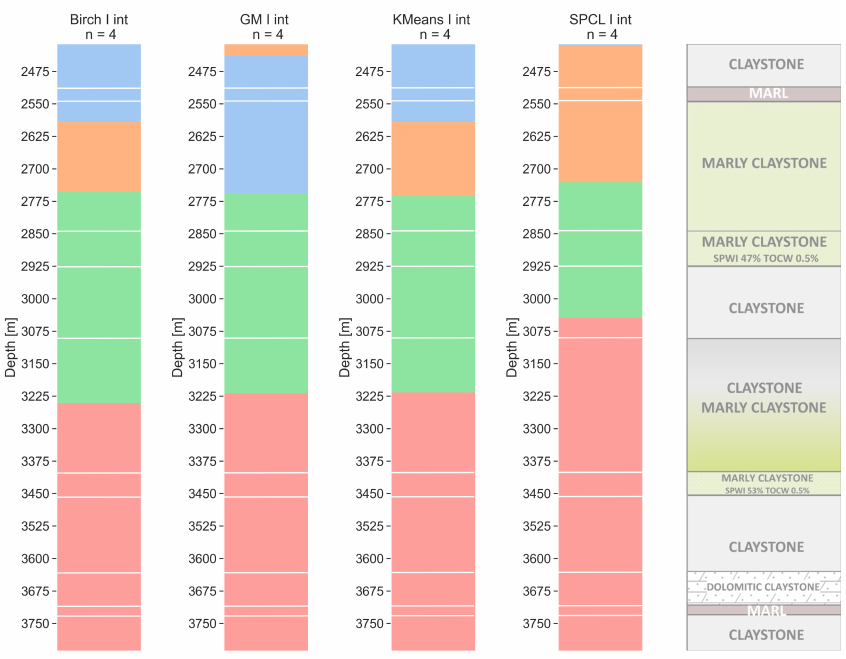
Figure 7. Sonic tool resolution clustering models for a number of clusters equal to 4 with lithology from well core (with lines). Clustering methods: BIRCH—balanced iterative reducing and clustering using hierarchies, GM—Gaussian mixture model, k-means, and SPCL—spectral